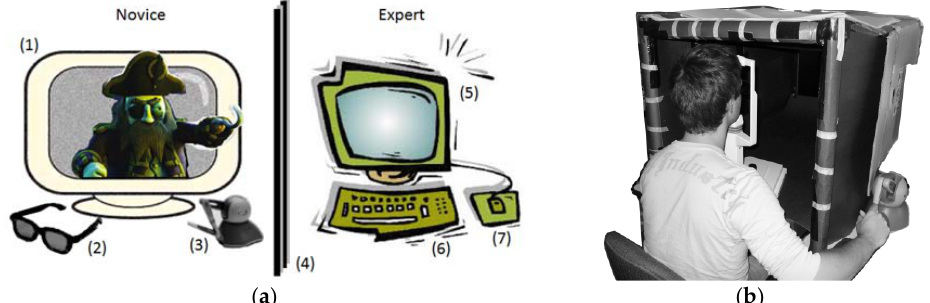
Figure 1. ( a ) Devices used in the collaborative virtual environment (CVE) and its side ‐ by ‐ side setup.